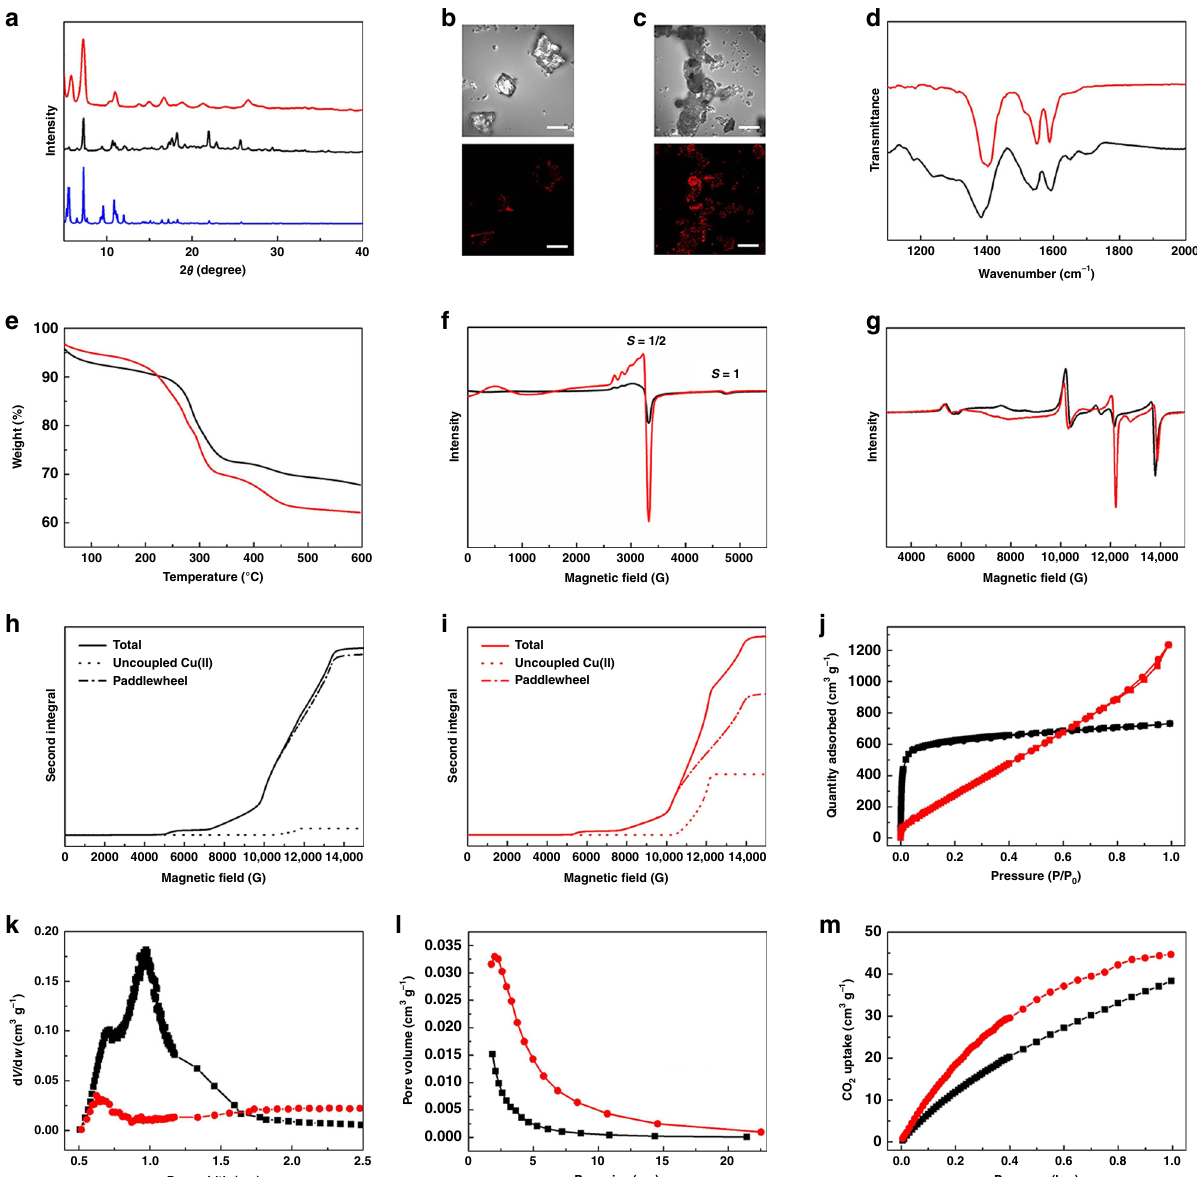
Fig. 2 Characterisations of Cu 2 (L)-t (black lines) and Cu 2 (L)-e (red lines). a PXRD patterns (blue line refers to simulated PXRD pattern). The defects in Cu 2 (L)-e result in broadening of peaks due to poorer crystallinity of the material. b Micrograph (top) and CFM image (bottom) of Cu 2 (L)-t. The fl uorescence (shown in red colour) indicates the presence of crystal defects determined by the oligomerisation of furfuryl alcohol. c Micrograph (top) and CFM image (bottom) of Cu 2 (L)-e. d Selected FTIR spectra (full spectra are shown in Supplementary Information). e TGA curves. f X-band EPR spectra at room temperature. g Q-band EPR spectra at room temperature. h Second integrals from simulated Q-band EPR spectra for Cu 2 (L)-t. i Second integrals from simulated Q-band EPR spectra for Cu 2 (L)-e. j N 2 adsorption/desorption isotherms at 77 K. k Micropore size distribution. l Mesopore size distribution. m Adsorption isotherms for CO 2 at 298K (desorption data are shown in Supplementary Information). Data for HKUST-1-e are shown in Supplementary Information. The scale bars of b and c are 20 μ